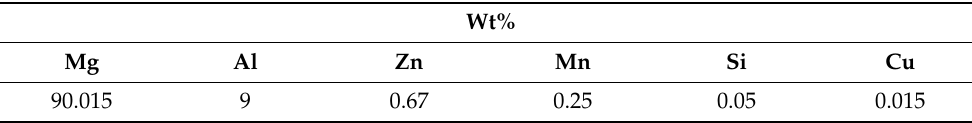
Table 1. Chemical composition of AZ91D alloy